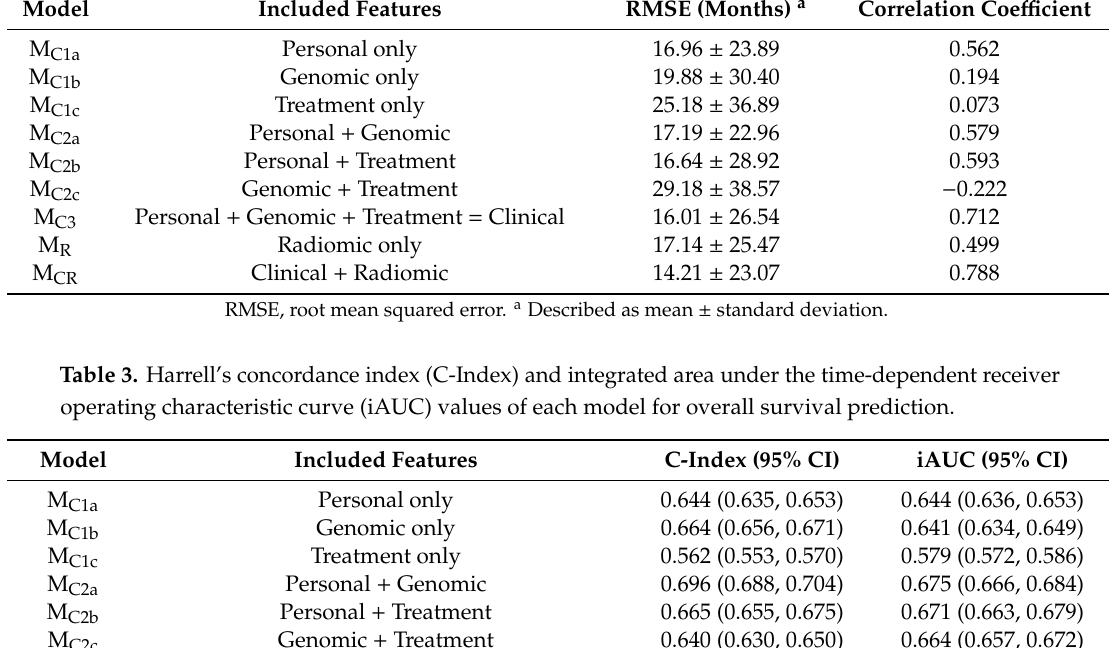
Table2. Rootmeansquarederrorandcorrelationcoe ffi cientofeachmodelforoverallsurvivalprediction. Table 2. Root mean squared error and correlation coefficient of each model for overall survival prediction.